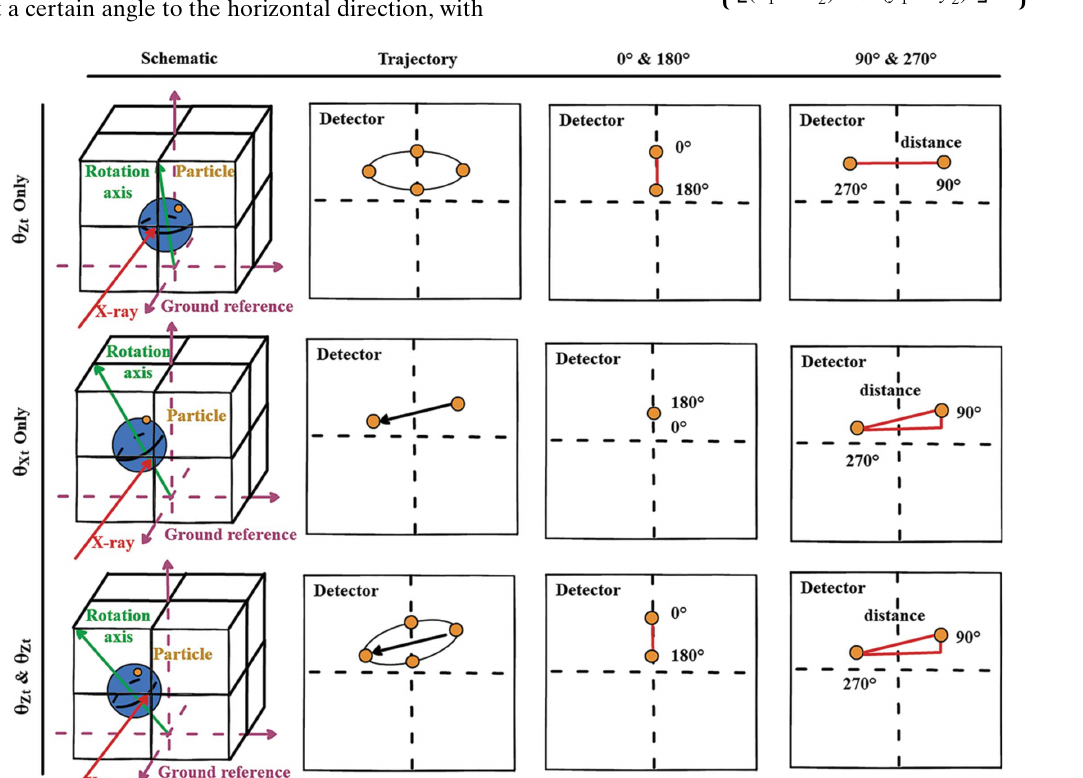
Figure 3 Particle trajectories under different rotation-axis misalignment situations.